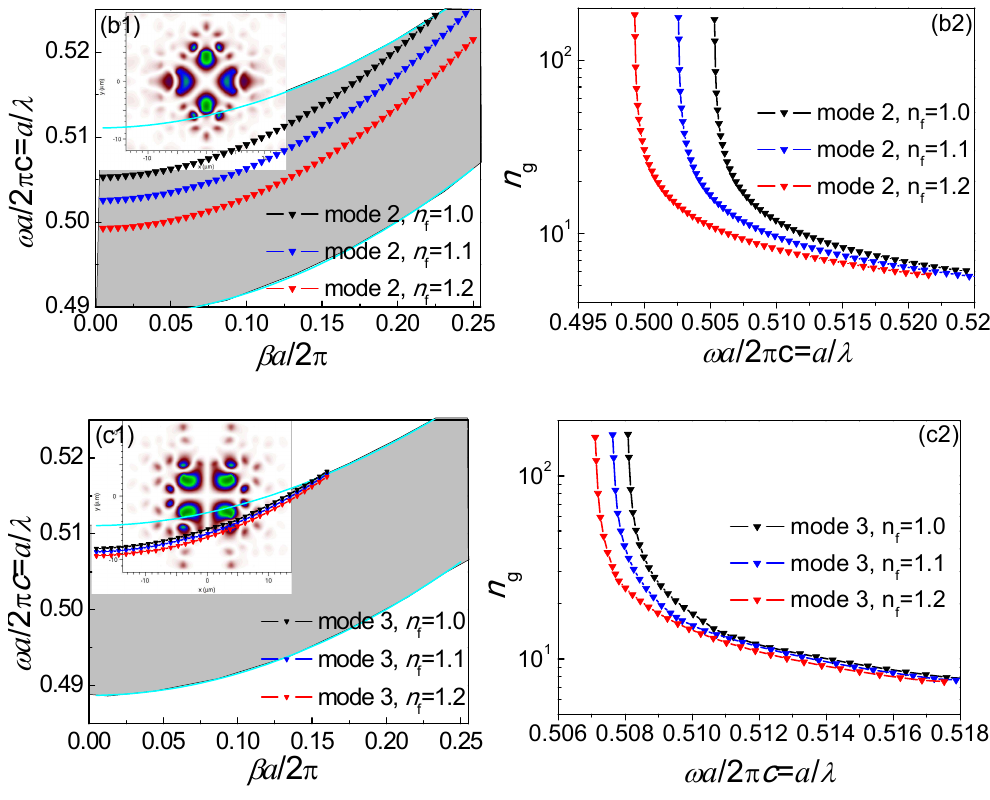
Figure 2. Photonic band gap and group index of infiltrated HC-PBF; ( a1 , a2 ) mode 1, ( b1 , b2 ) mode 2, and ( c1 , c2 ) mode 3. Field distributions of guided optical modes 1–3 in the HC-PBF with slow-light effect are also shown in Figures a1, b1, and c1, respectively.